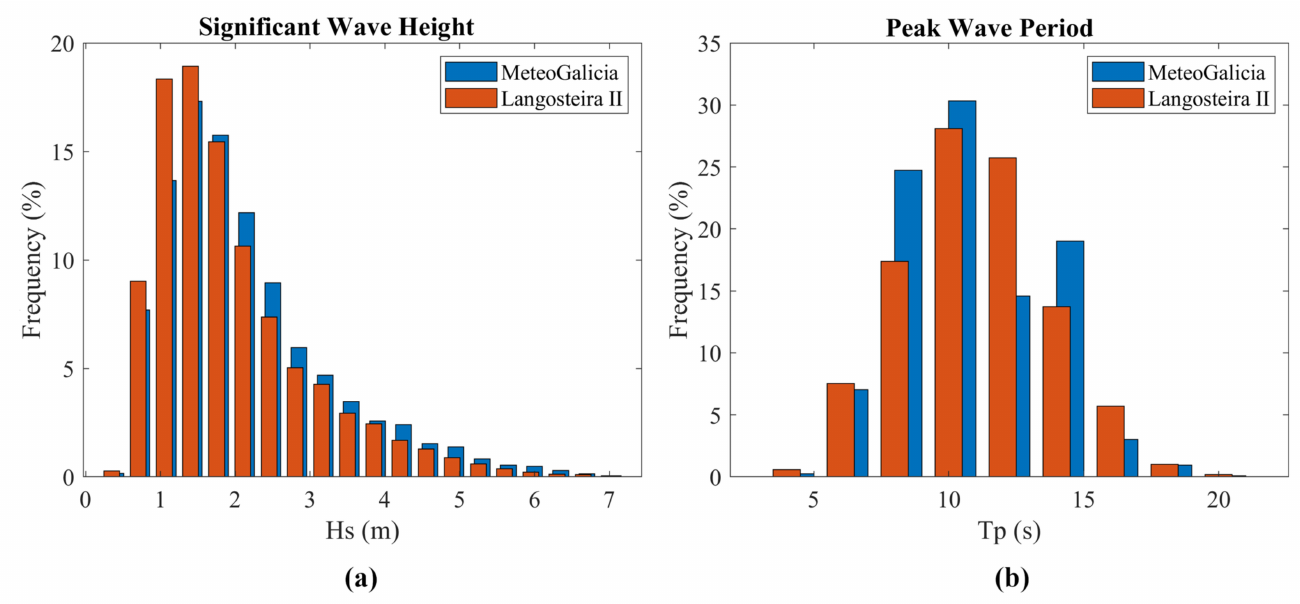
Figure 2. Histograms for ( a ) H s and ( b ) T p from the SWAN simulations (blue) and the Langosteira II buoy measures (red).